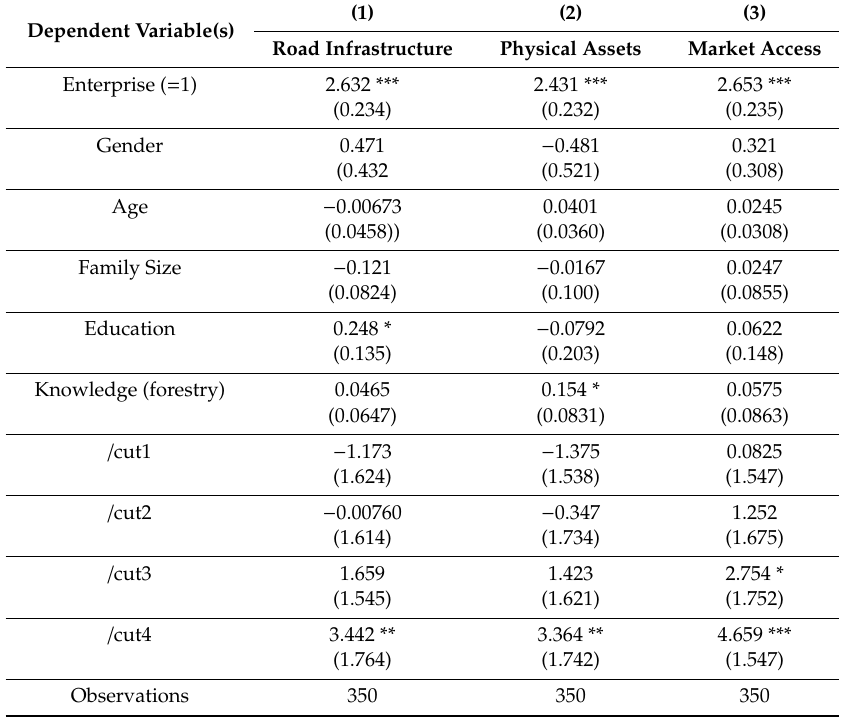
Table 7. BTAP and physical capital.